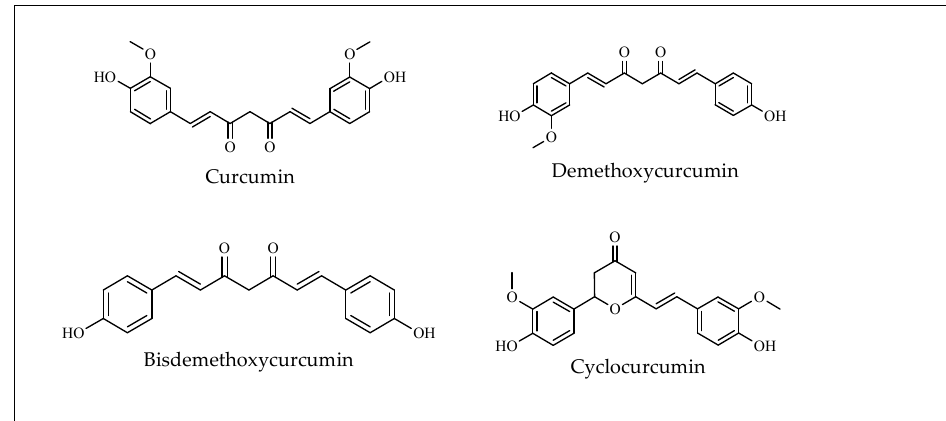
Figure 17. Carcuminoid